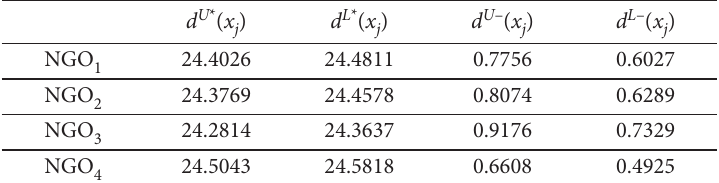
Table 9.The separation measure of each alternative and the closeness coefficient